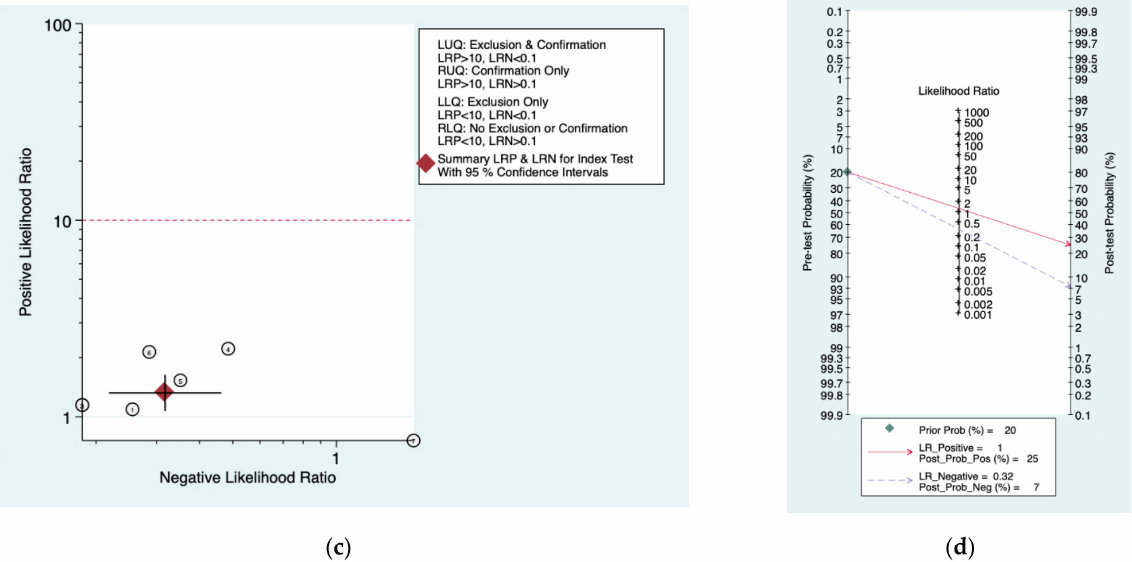
Figure 3. Meta‑analysis of Sunderland protocol. ( a ) Forrest plot of pooled sensitivity and speci‑ ficity [8,10,22,24,25]; ( b ) Hierarchical summary receiver operating characteristic (HSROC) curve; ( c ) Likelihood ratio scattergram; ( d ) Fagan nomogram.